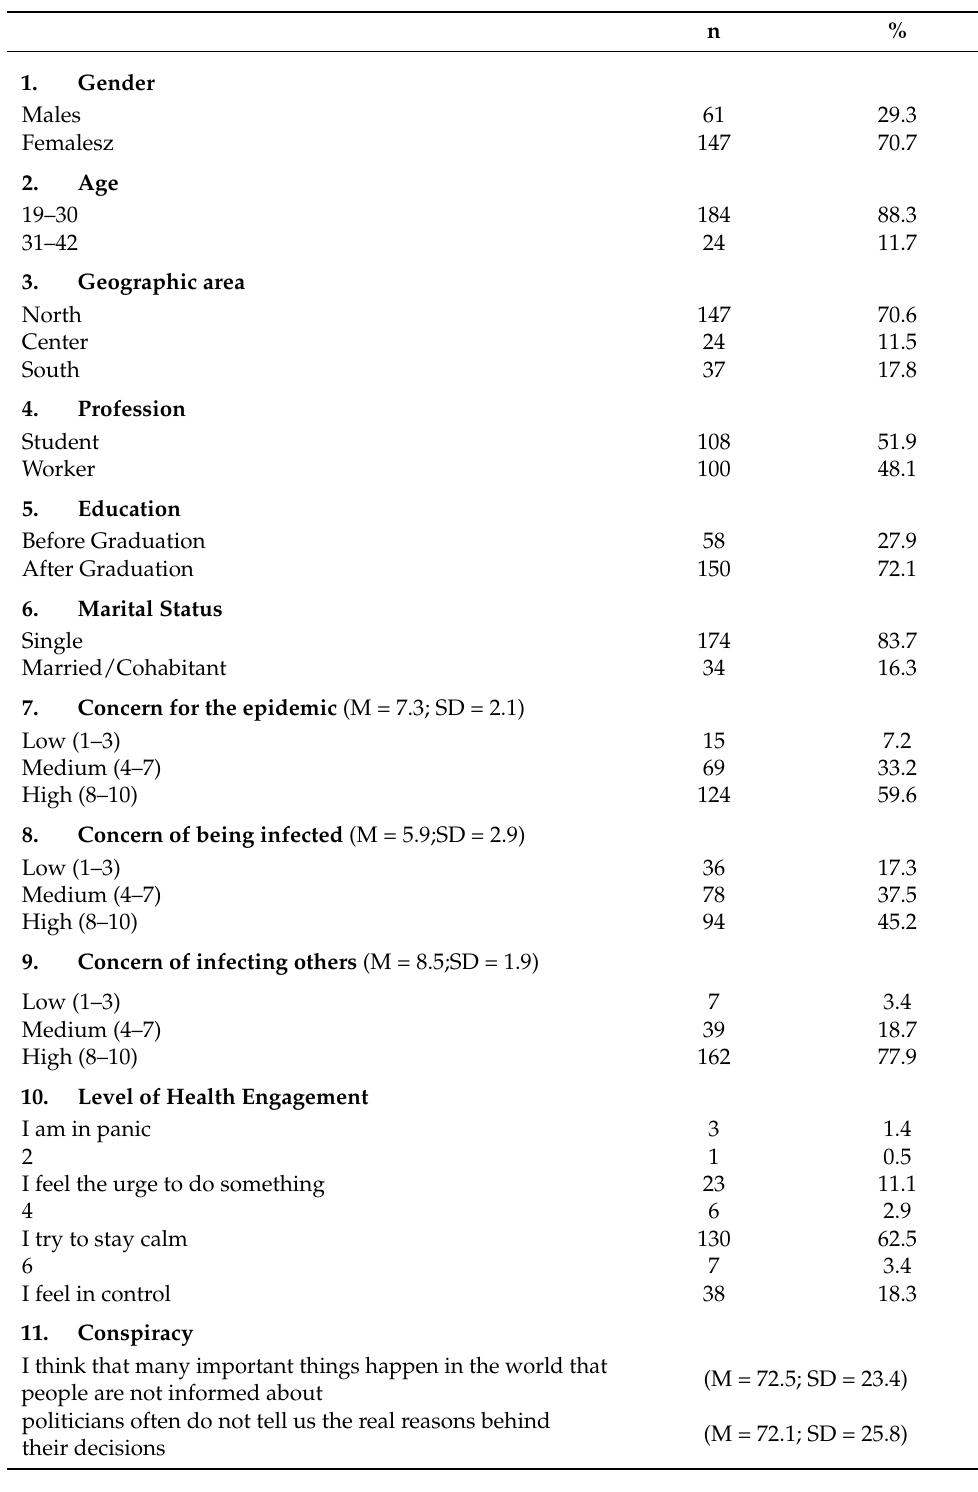
Table 2. Demographic and psychosocial characteristics of the sample (n =